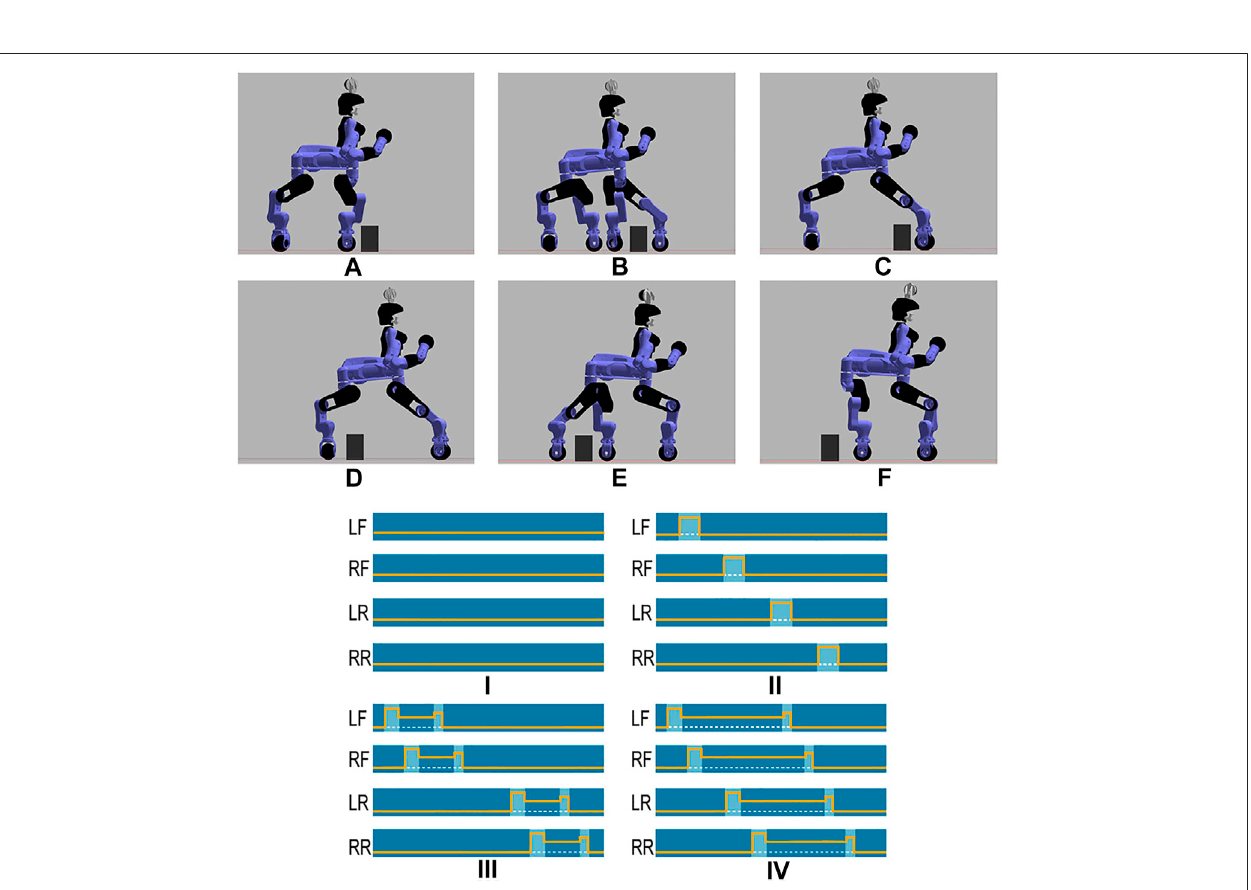
FIGURE 10 | Sequence of the stepping over strategy applied in simulation environment with an Obstacle-A. (A) We approached the obstacle, stopping at a safety distance from it, (B) step over with the left front wheel, (C) step over with the right front wheel, (D) drive, stopping with the rear wheels close to the object, (E) step over with the left rear wheel, (F) step over with the right rear wheel, completing the task. In the bottom you can see the motion modalities considered in the framework. Dark bluecolorindicatesthatthecorrespondingwheelisincontactwiththeground;theorangelineinsteadistheZvalueofthewheel,whilethedashedwhiteoneshows the terrain level. (I) Driving on fl at surface, (II) Traversing Over an obstacle modality making use ofsequential stepping over primitives on the individual legs, (III) Traversing modality for a small depth obstacle making use of stepping on and stepping down primitives executed by the four legs, (IV) Traversing modality for a large depth obstacle making use of stepping on and stepping down primitives executed by the four legs.